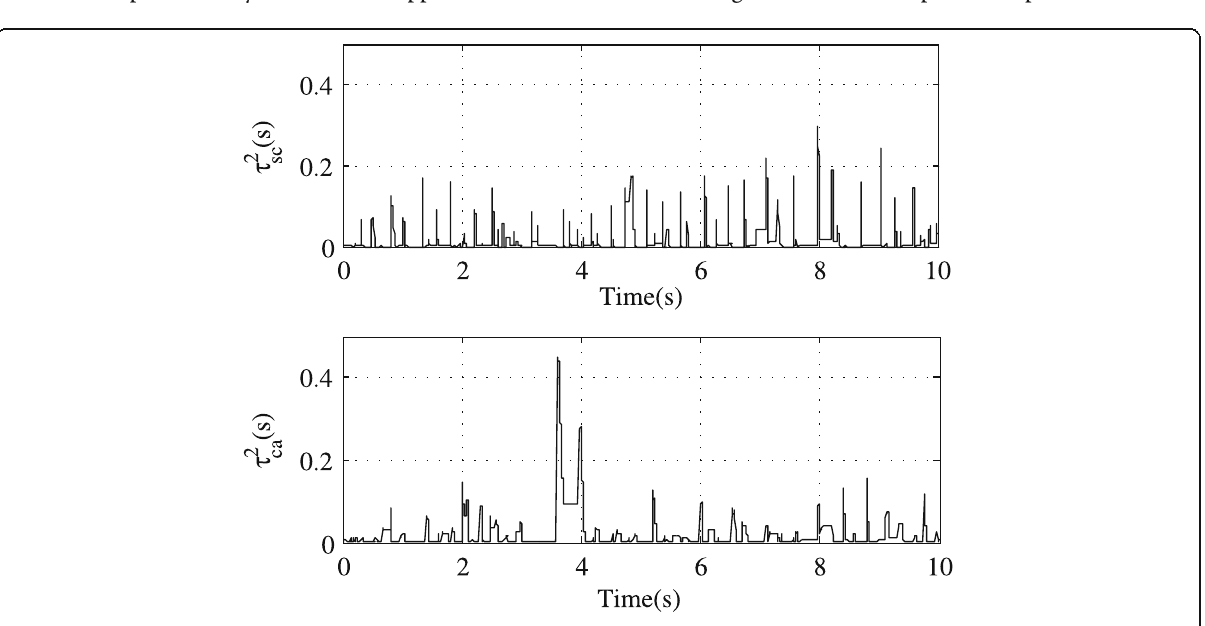
Fig. 12 The SC and CA delay distributions of loop 2 when parameter perturbation and communication network